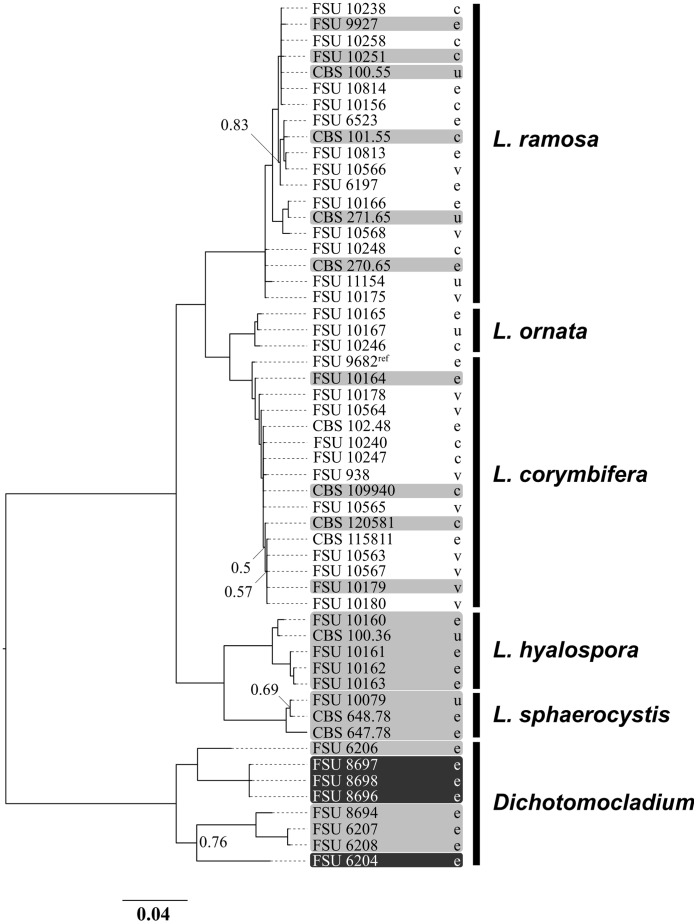
Phylogenetic tree of all used strains.Phylogenetic tree based on ITS, 28S and 18S rDNA sequences of 46 Lichtheimia isolates from environmental (e), veterinary (v) and clinical (c) sources. Source was not known for 6 strains (u). Strains attenuated in comparison to L. corymbifera FSU 9682 (ref) are highlighted in light gray. Strains which were unable to grow at 37°C (not used for infection experiments) are highlighted in dark grey. Only bootstrap values below 0.9 are indicated.